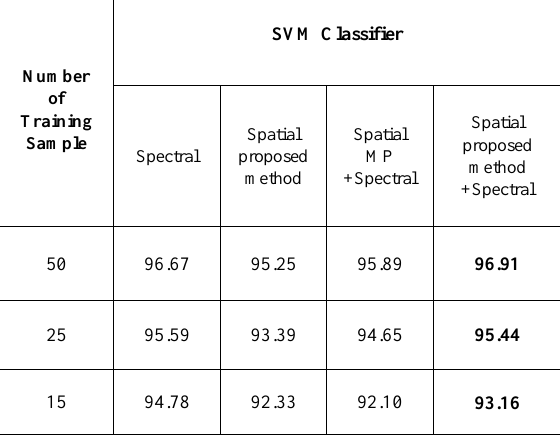
Table 1: Overall accuracy (OA) on the Pavia University dataset